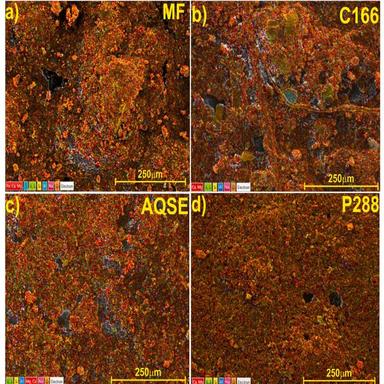
SEM micrographs, at ×200 magnification, for all mortars: a) MF, b) C166, c) AQSE and d) P288.